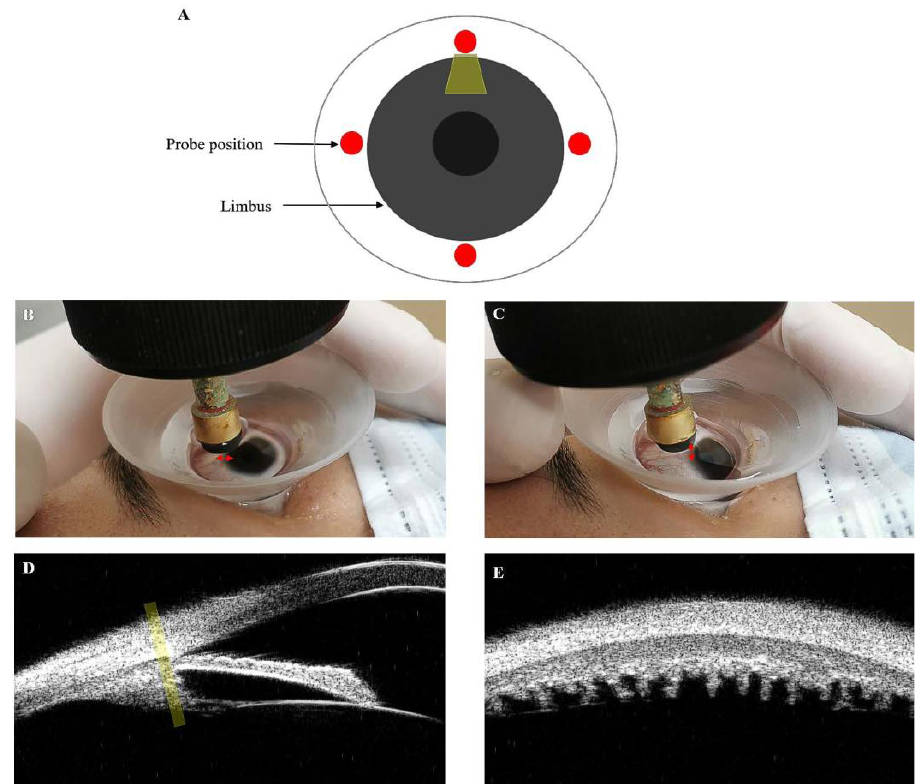
Figure 1. UBM was used to obtain the images of the ciliary body. The ultrasound beam appears in yellow. ( A ) Enface view with the probe position at 9, 12, 3, and 6 o’clock perpendicular to the limbus in red. ( B , C ) These images show the position of probes and eyes when obtaining superior radial and transverse UBM images, respectively. The red arrow shows the direction in which the probe swings during the examination. ( D ) This UBM image shows the relationship of the ultrasound beam to the CB when the transverse scan is performed. ( E ) This image depicts a transverse (superior) UBM image.